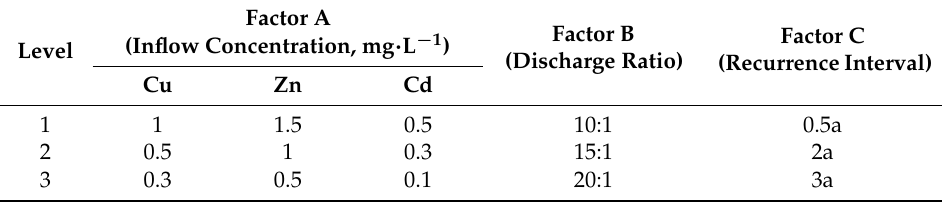
Table 3. Different levels of factors.